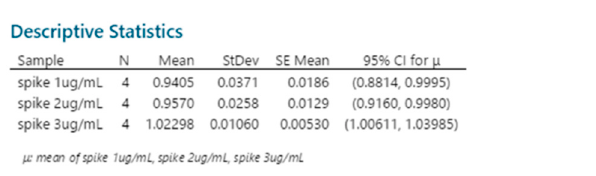
Figure A18. Linear regression analysis for sample Linearity determination for quantification of S. flexneri 6 OAg by HPAEC-PAD (data from single analysis session #4–6).